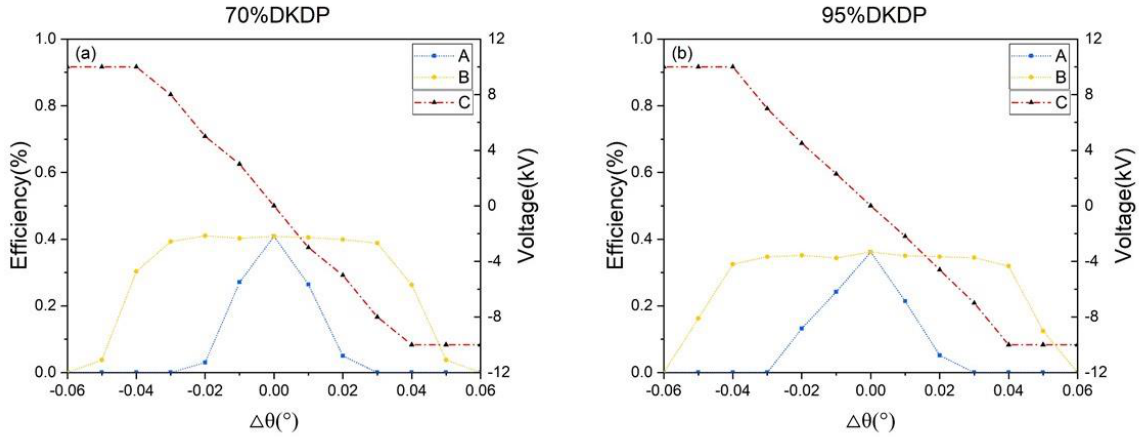
Figure 6. Experimental OPA efficiencies obtained via ( a ) 70%- and ( b ) 95%-deuterated DKDP versus angle and compensation voltage. Line A represents the OPA efficiency without compensation, Line B indicates OPA efficiency where the phase mismatch is compensated, and Line C represents the compensation voltage.